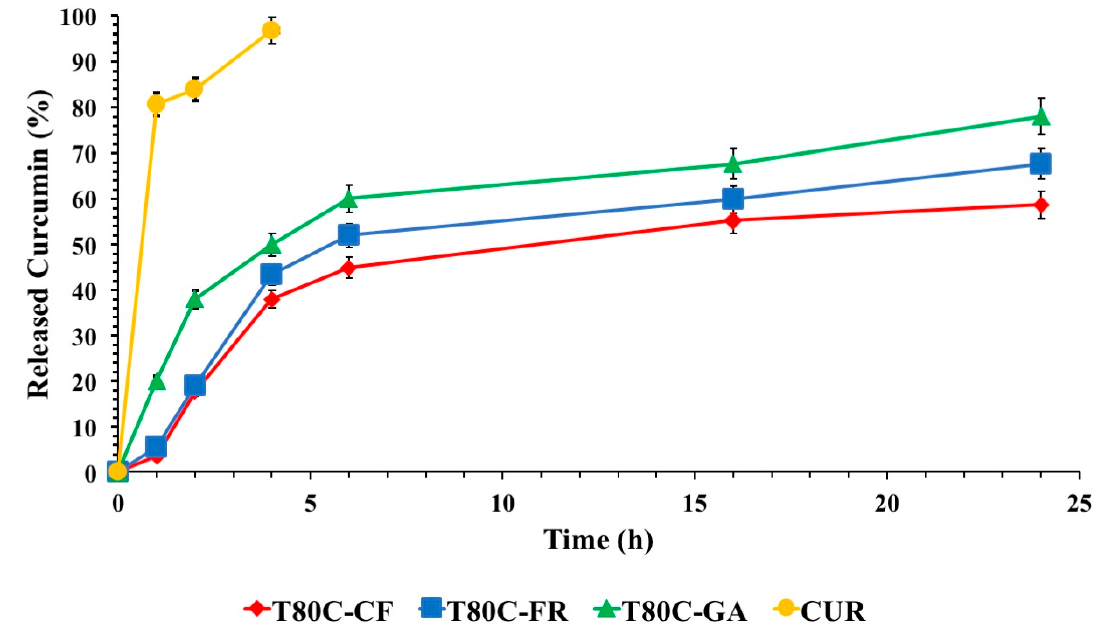
Figure 6. In vitro CUR release in phosphate buffer pH 7.4 (Tween 80 0.5%) at 37 °C from T80C-GA ( ▲ ), T80C-CF ( ♦ ), T80C-FR ( ■ ), CUR solution (•). In all cases, each value represents the mean ± S.D. of three independent experiments.